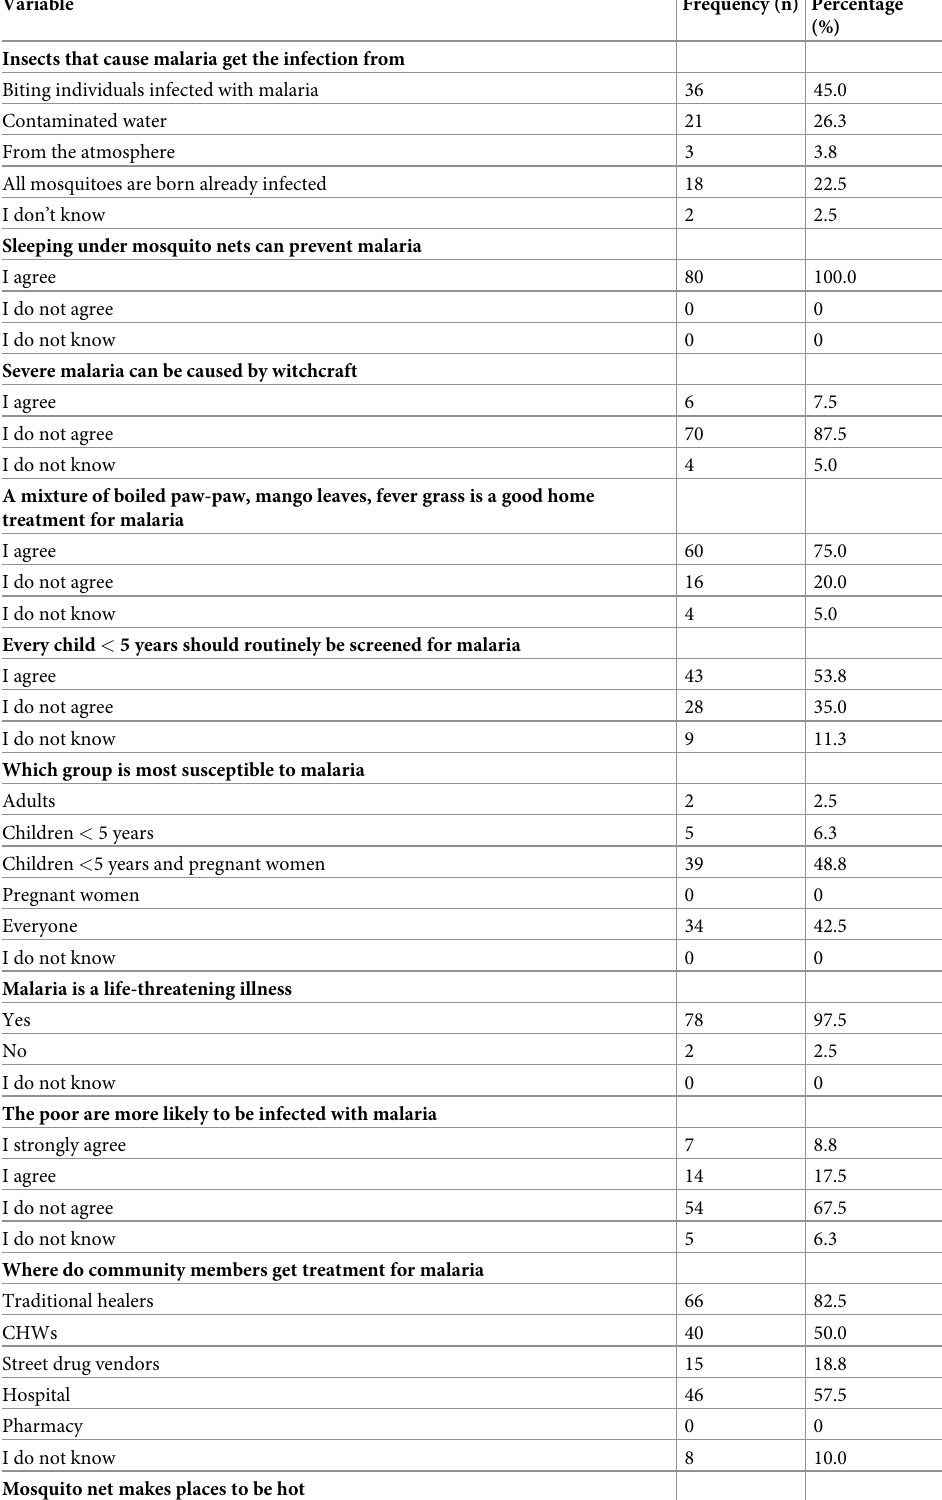
Table 4. CHWs’ attitude on childhood malaria management and